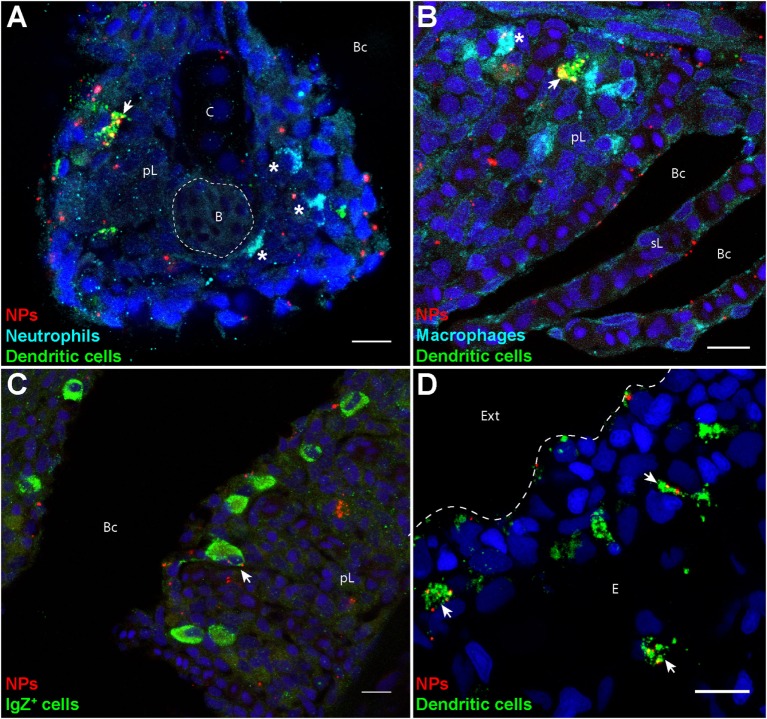
Poly(lactic acid) nanoparticles (PLA-NPs) are accumulated in mucosal antigen-presenting cells. (A–D) Representative confocal images of gills (A–C) and skin (D) of wild-type adults immersed for 24 h in 0.01% fluorescent PLA-NPs (red). Images were acquired from 40-μm-thick whole-body cryosections, stained for neutrophils (Mpx-positive, cyan) (A), macrophages (Mpeg1-positive, cyan) (B), IgZ+ B-cells (green) (C), and dendritic cells (DCs) (PNA, green) (A,B,D), in addition to nuclei (DAPI, blue). Maximal intensity projections from 3 (A–C) or 5 (D) optic sections acquired every micrometer. Nanoparticle (NP) accumulations are observed in gill DCs [(A,B), arrows], macrophages [(B), star], and IgZ+ cells [(C), arrow], while no NP are detected in neutrophils [(A), stars]. NPs are also taken up by a network of skin DCs [(D), arrows]. pL, primary lamellae; sL, secondary lamellae; Bc, branchial cavity; B, blood; C, cartilage; Ext, external environment; E, epidermis. Scale bar: 10 μm.